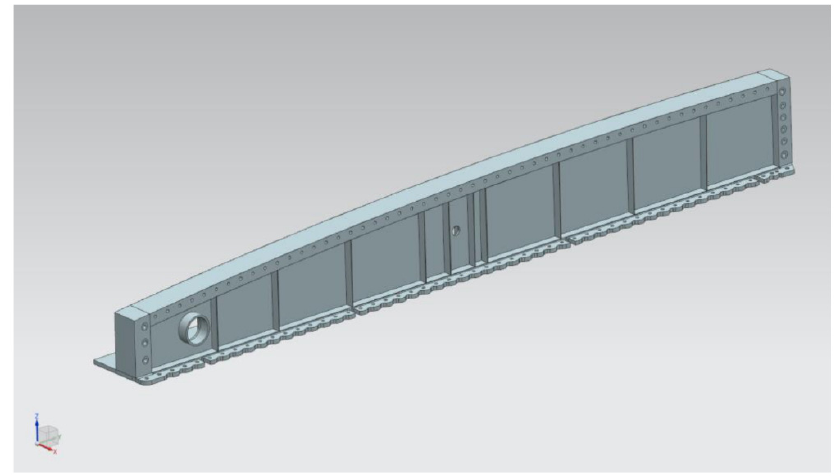
Figure 6. Wing root CAD model.